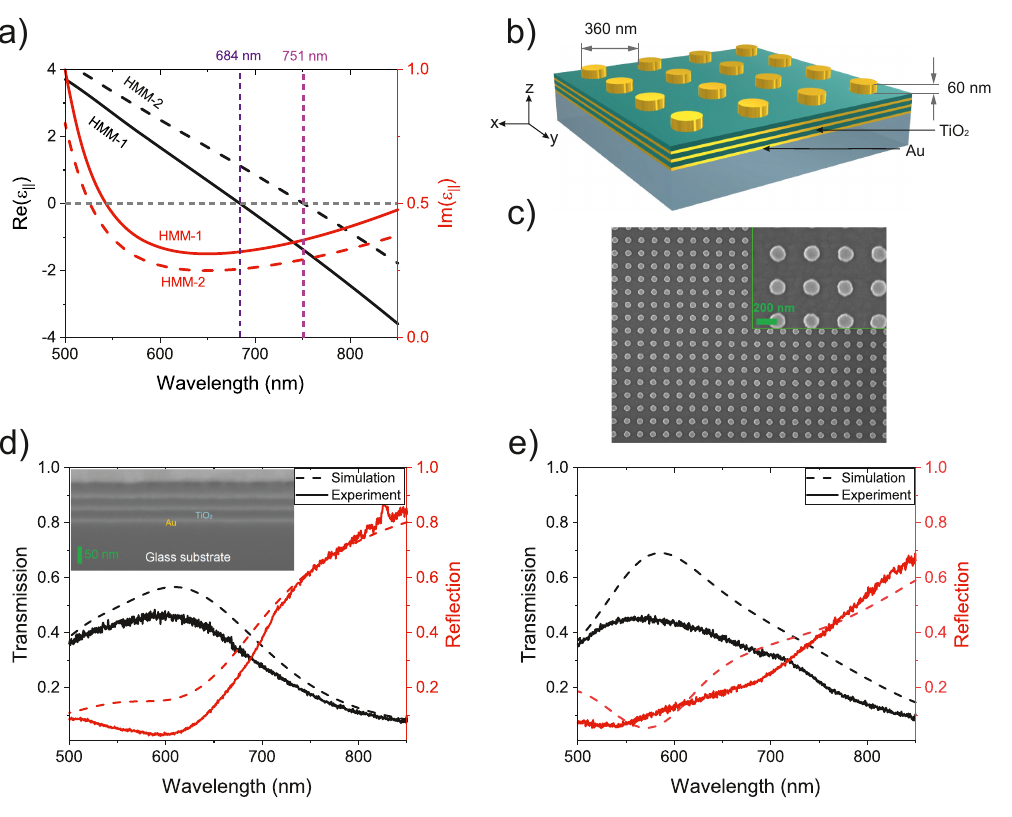
Figure 1: (a) The Re( ε ∥ ) (black lines) and Im( ε ∥ ) (red lines) of HMM-1 (solid lines) and HMM-2 (dashed lines). The crossover of Re( ε ∥ ) for HMM-1 (violet dotted line) and HMM-2 (magenta dotted line) are highlighted. (b) The schematic of NDs on HMM and (c) the scanning electron microscopy (SEM) image of NDs on HMM-1. The simulated (dashed lines) and measured (solid lines) spectra of transmission (black lines) and re fl ection(redlines)resultsfor(d)HMM-1and(e)HMM-2.Theinsetof(d)showstheSEMimageofHMM-1.HMM,hyperbolicmetamaterial;ND,